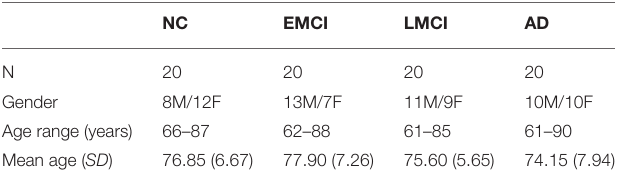
TABLE 1 | Demographics information for ANDI participants, arranged into NC, EMCI, LMCI, and AD